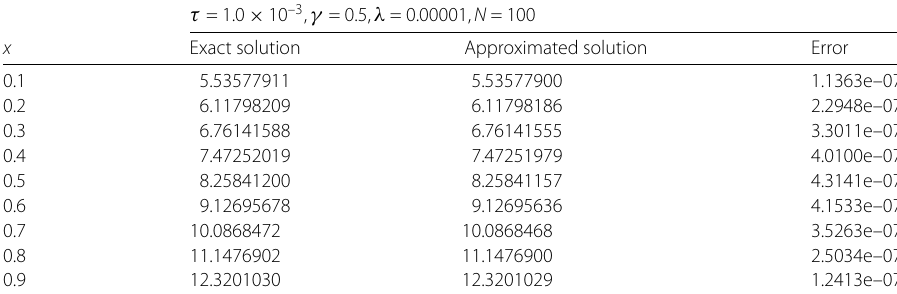
Table 4 A comparison of exact solution and approximated solution at T = 1 for problem-1